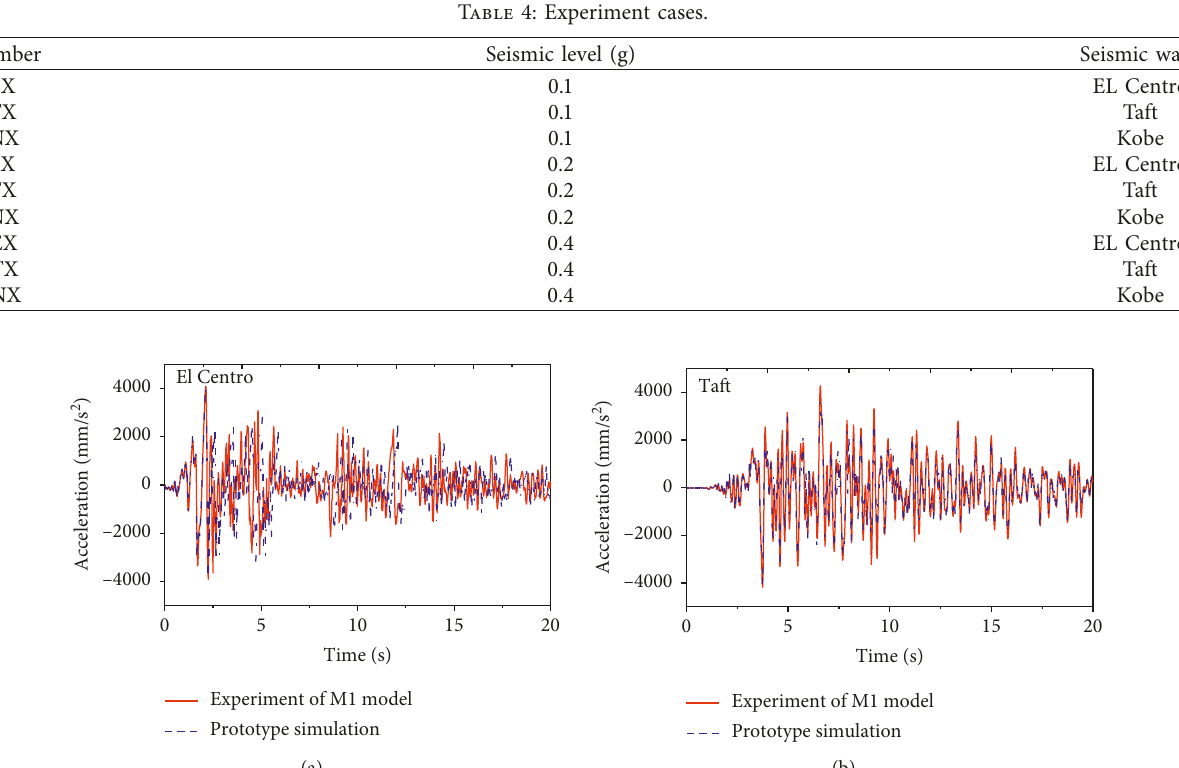
Figure 8: Acceleration versus time data of prototype and M1model at measurement point